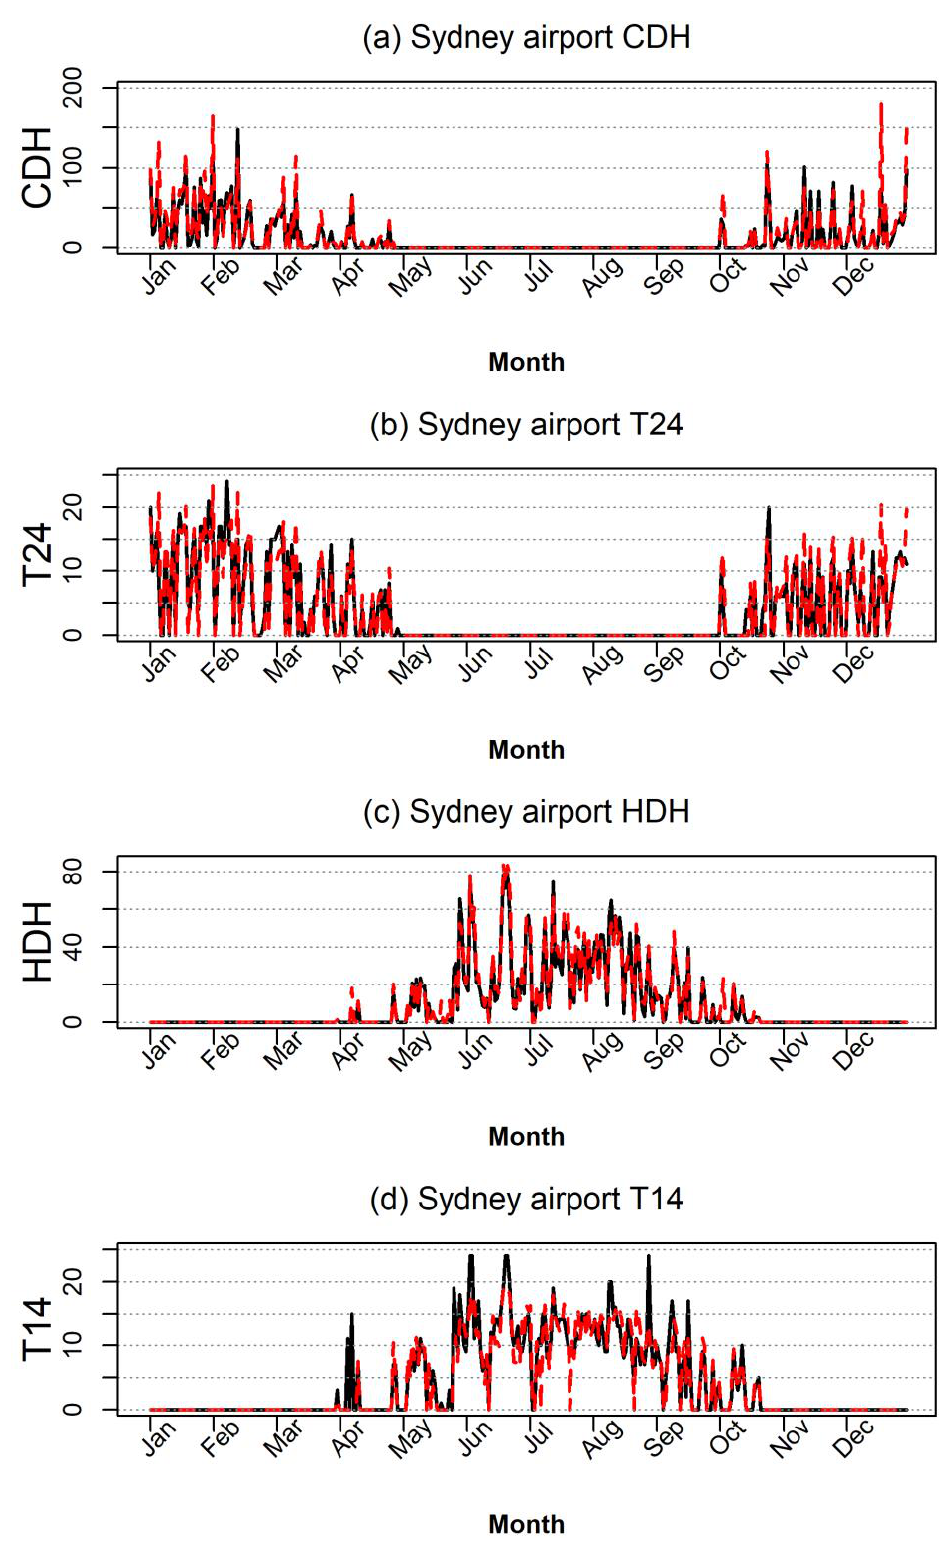
Figure 9. Observed (black solid) and estimated (red dotted line) from the empirical models CDH, T24, HDH and T14 values for the year 2019 at Sydney airport station.